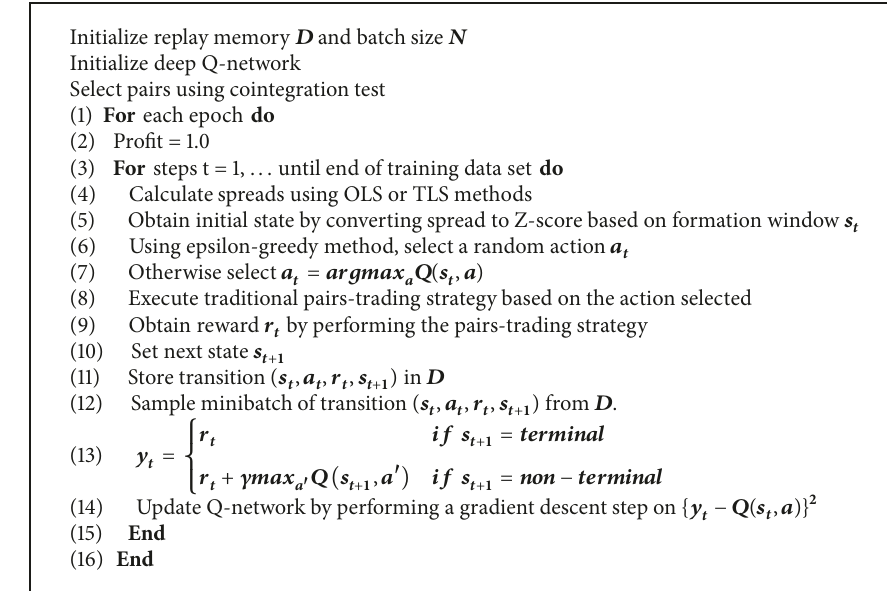
Algorithm 1: Optimized pairs-trading system using